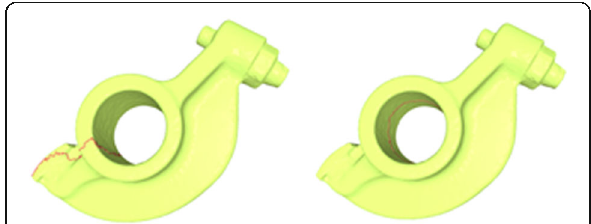
Fig. 1 Homology group basis for a graph embedded on a genus one